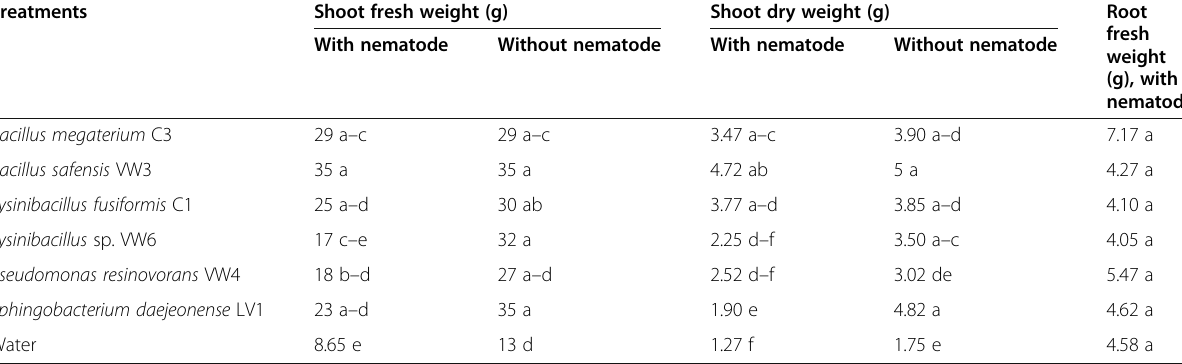
Data are the means of 4 replicates. Values in the same column followed by the same letter(s) are not significantly different ( P ≤ 0.05), according to Duncan ’ s multiple range